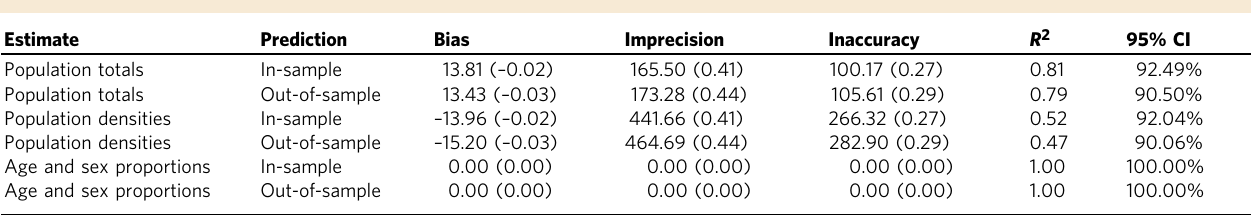
Table 1 Goodness-of- fi t metrics.